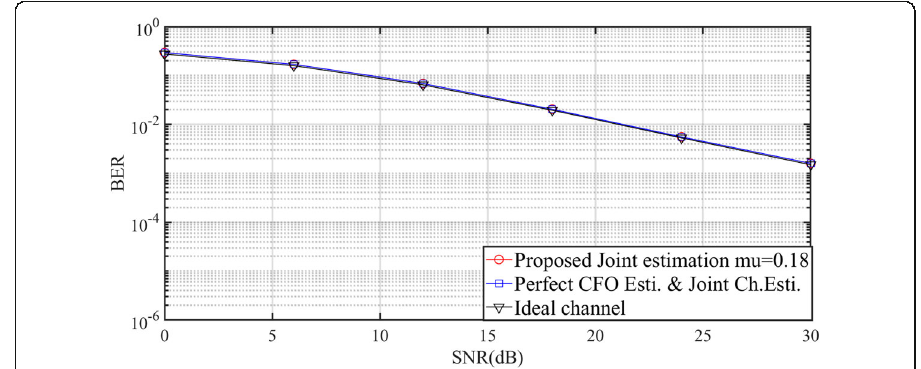
Fig. 16 The BER performance of the joint estimation in the adaptive mode at v = 500 km/h